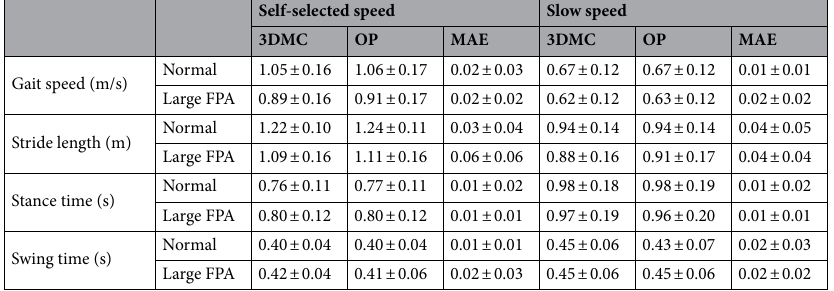
Table 1. Temporo-spatial parameters in the four gait conditions (mean ± SD). In large FPA conditions, participants were instructed to walk with an FPA of 50°. OP and proposed methods used the same calculation. MAE was averaged after calculating the absolute value of the difference between each participant’s data measured by two methods.